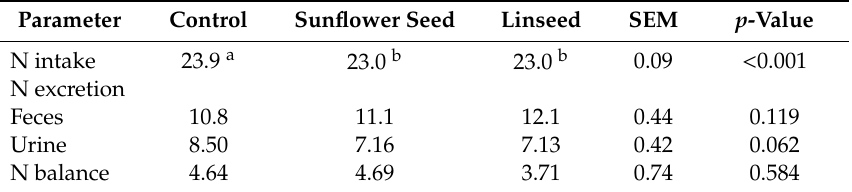
Table 4. Nitrogen balance (g N / d) in dairy goats fed control (Megalac-R ® ), sunflower (SF) and linseed (LS) treatments (n = 9 per